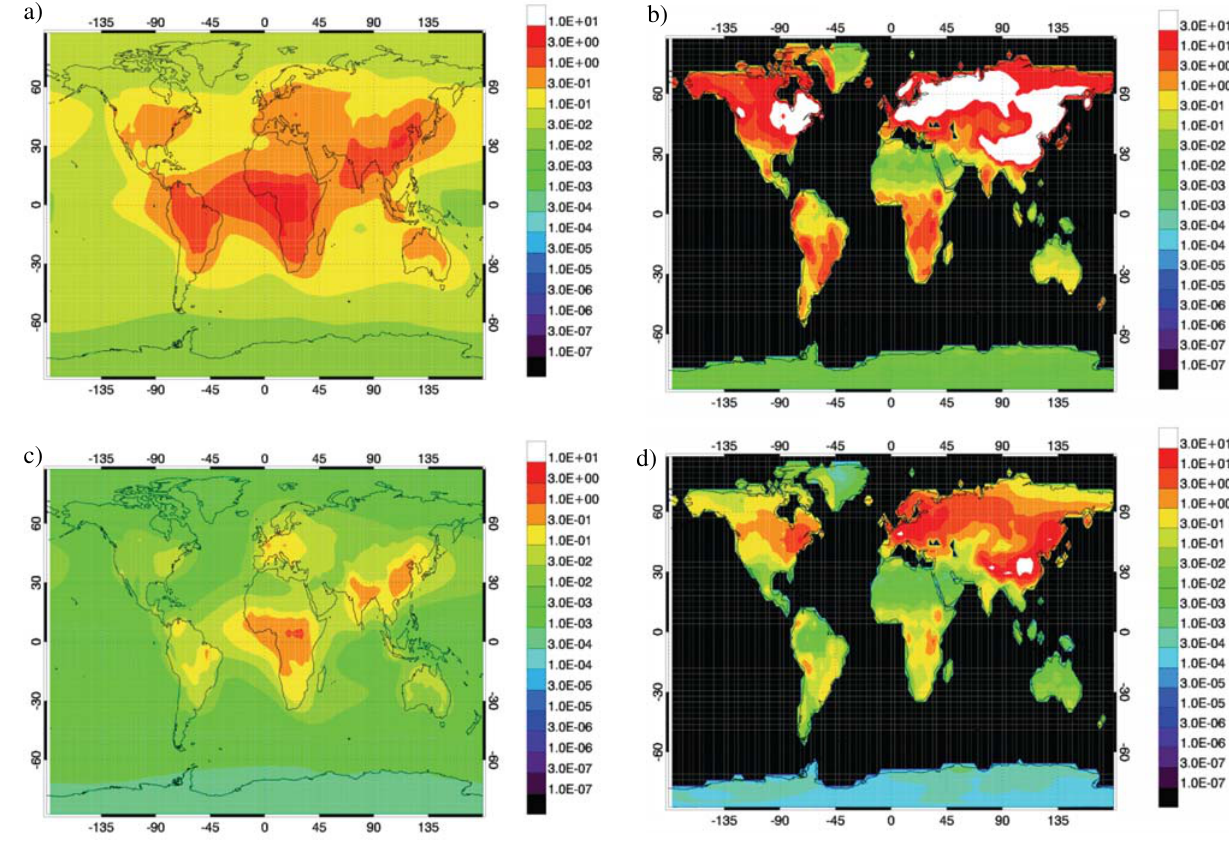
Fig. 2. Distributions of annual mean fluoranthene (FLT, a, c) and benzo(a)pyrene (BAP, b, d) burdens (μg m –2 ) in air (a, b) and soil (c, d) under the scenario assuming both absorption in organic matter and adsorption to soot to contribute to gas-particle partitioning (OB, see above 2.3).